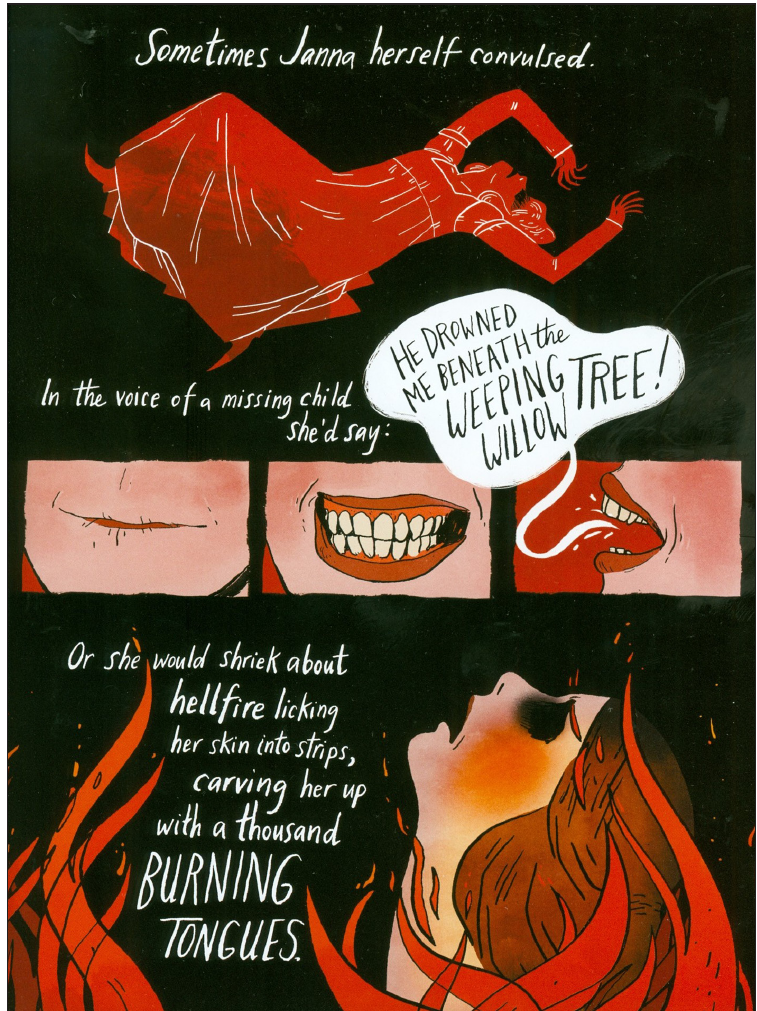
Figure 6: Carroll, E (2014). Through the Woods (New York: Faber & Faber, n.pag.) © Emily